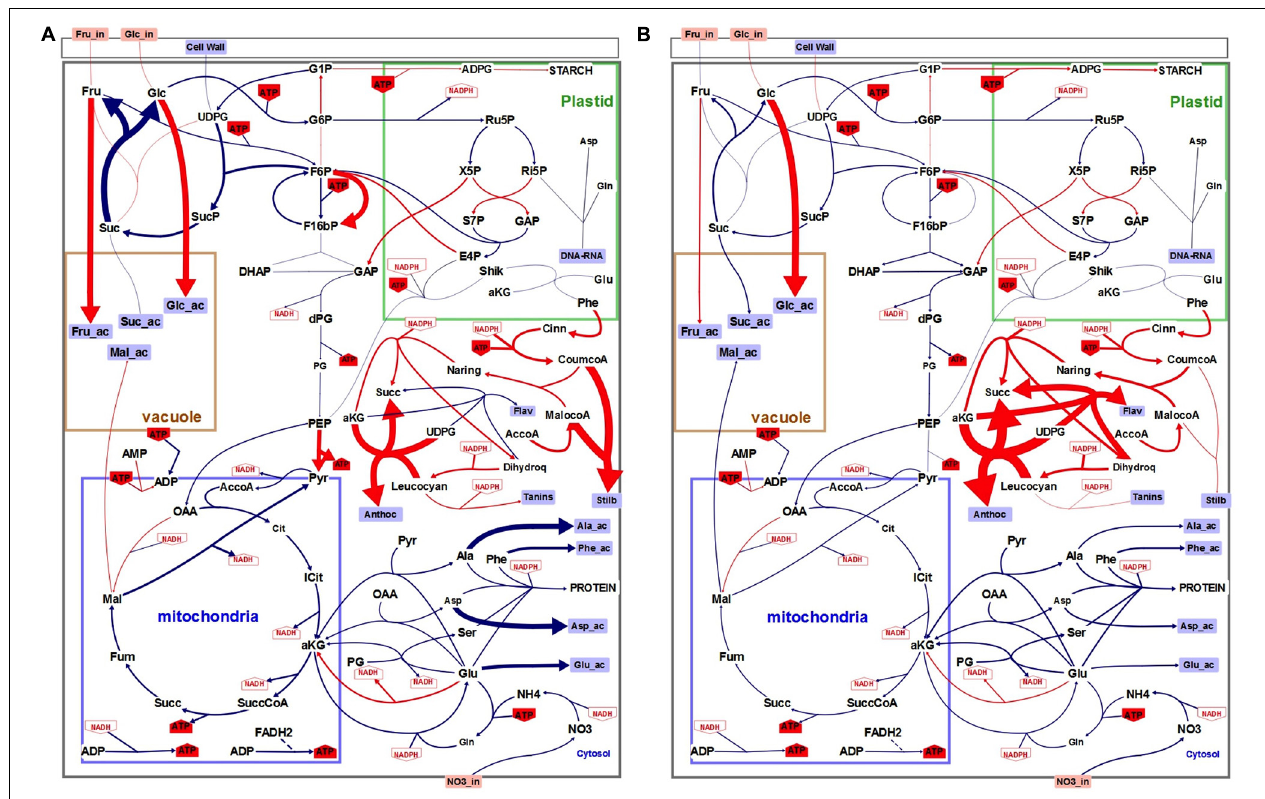
FIGURE 5 | Schematic representation of the flux variations between control (N) and low (N–) nitrogen culture conditions at day 4 (A) or 6 (B) . Each color indicates relative flux variations between the two conditions: blue indicates decreased fluxes and red increased fluxes. Size of the arrows is proportional to flux variation